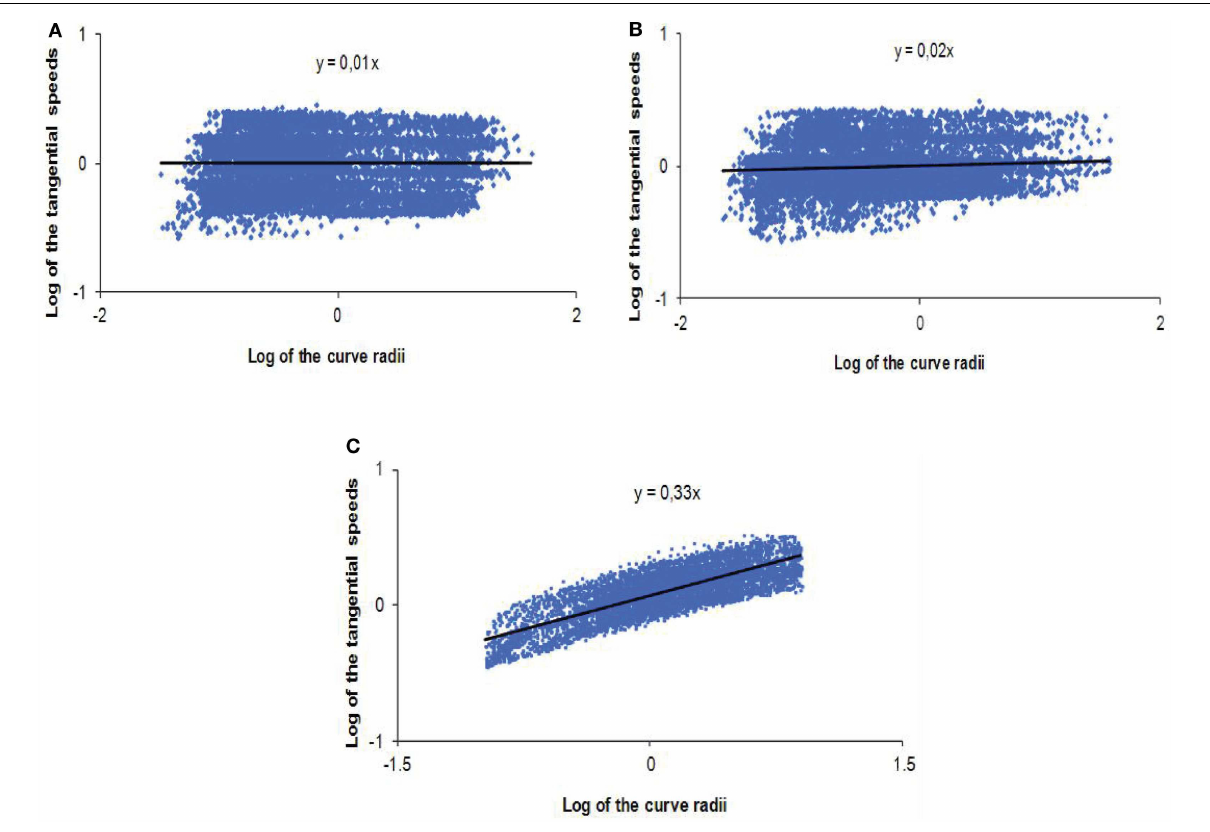
the tests in (A) the “control condition,” (B) the “non-human model” of anticipation, and (C) the “human-like model” of